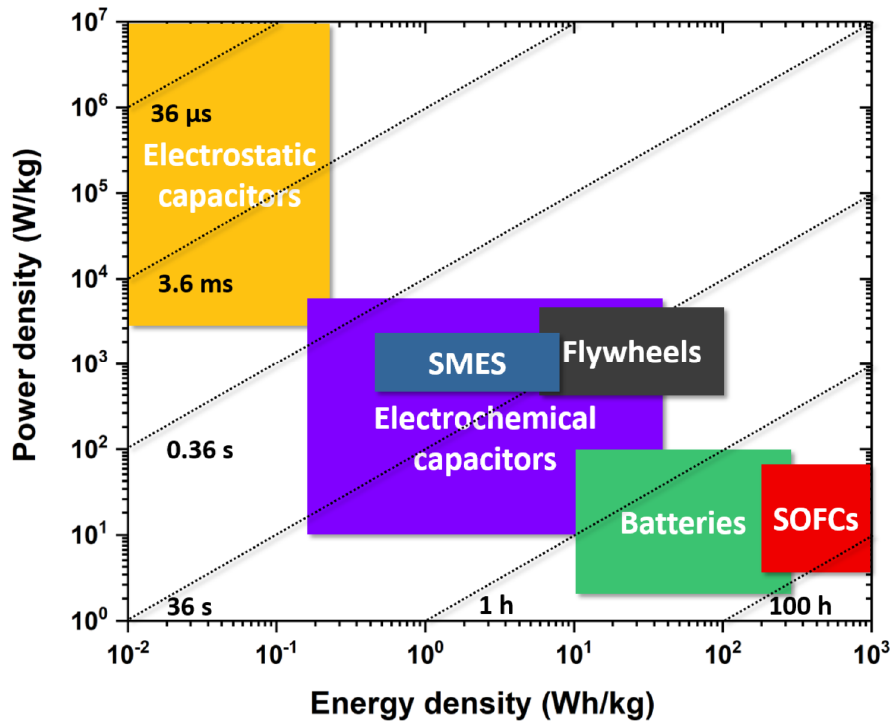
Figure 4. Ragone plot of different energy storage devices: electrostatic capacitors, electrochemical capacitors, SMES flywheels, batteries, and SOFCs [119]. SMES = superconducting magnetic energy storage; SOFCs = solid oxide fuel cells. Reproduced with permission from Elsevier.